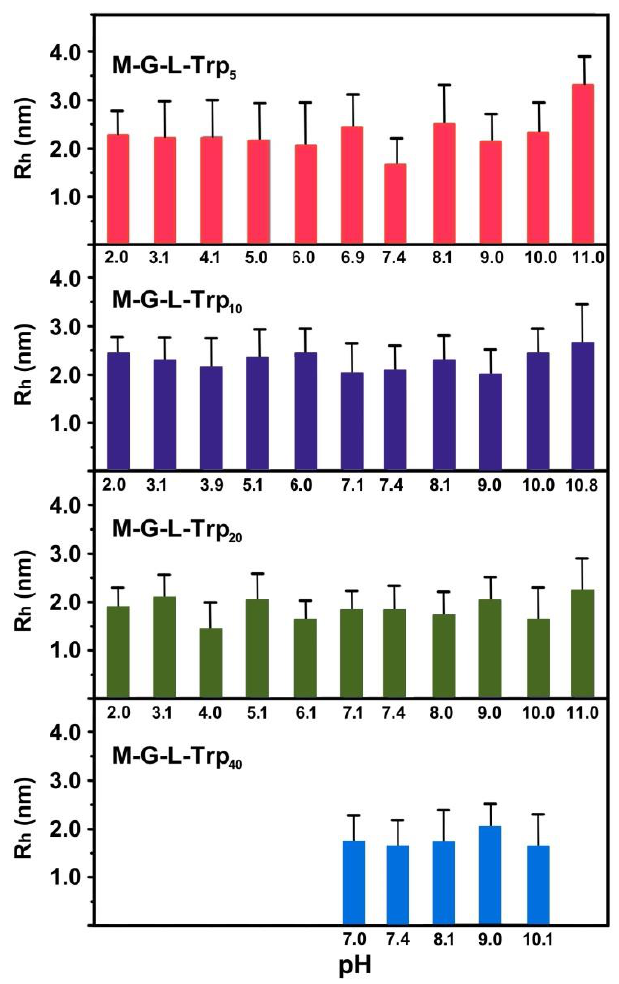
Figure 4. pH-dependence of the hydrodynamic radius of M-G- L -Trp copolymers. Data were obtained in 0.1 M NaCl at 1 mg·mL − 1 and 25 °C.